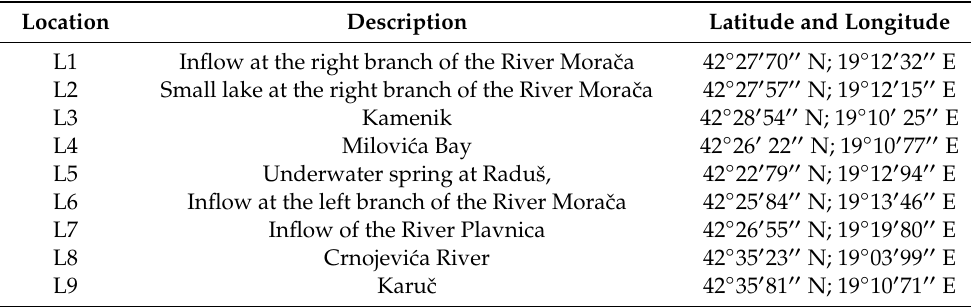
Table 2. Description and position of the sampling